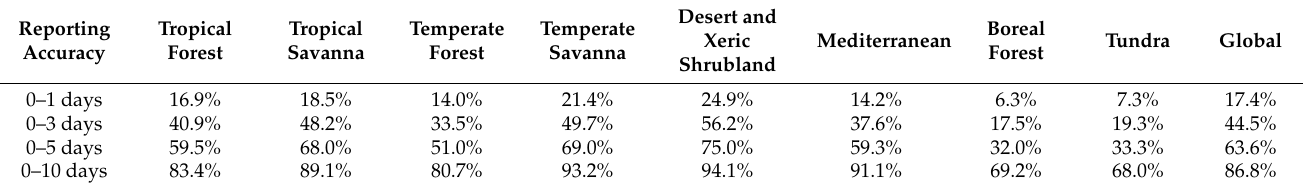
Table A1. Average (2017–2019) temporal reporting accuracies of the C3SBA10.